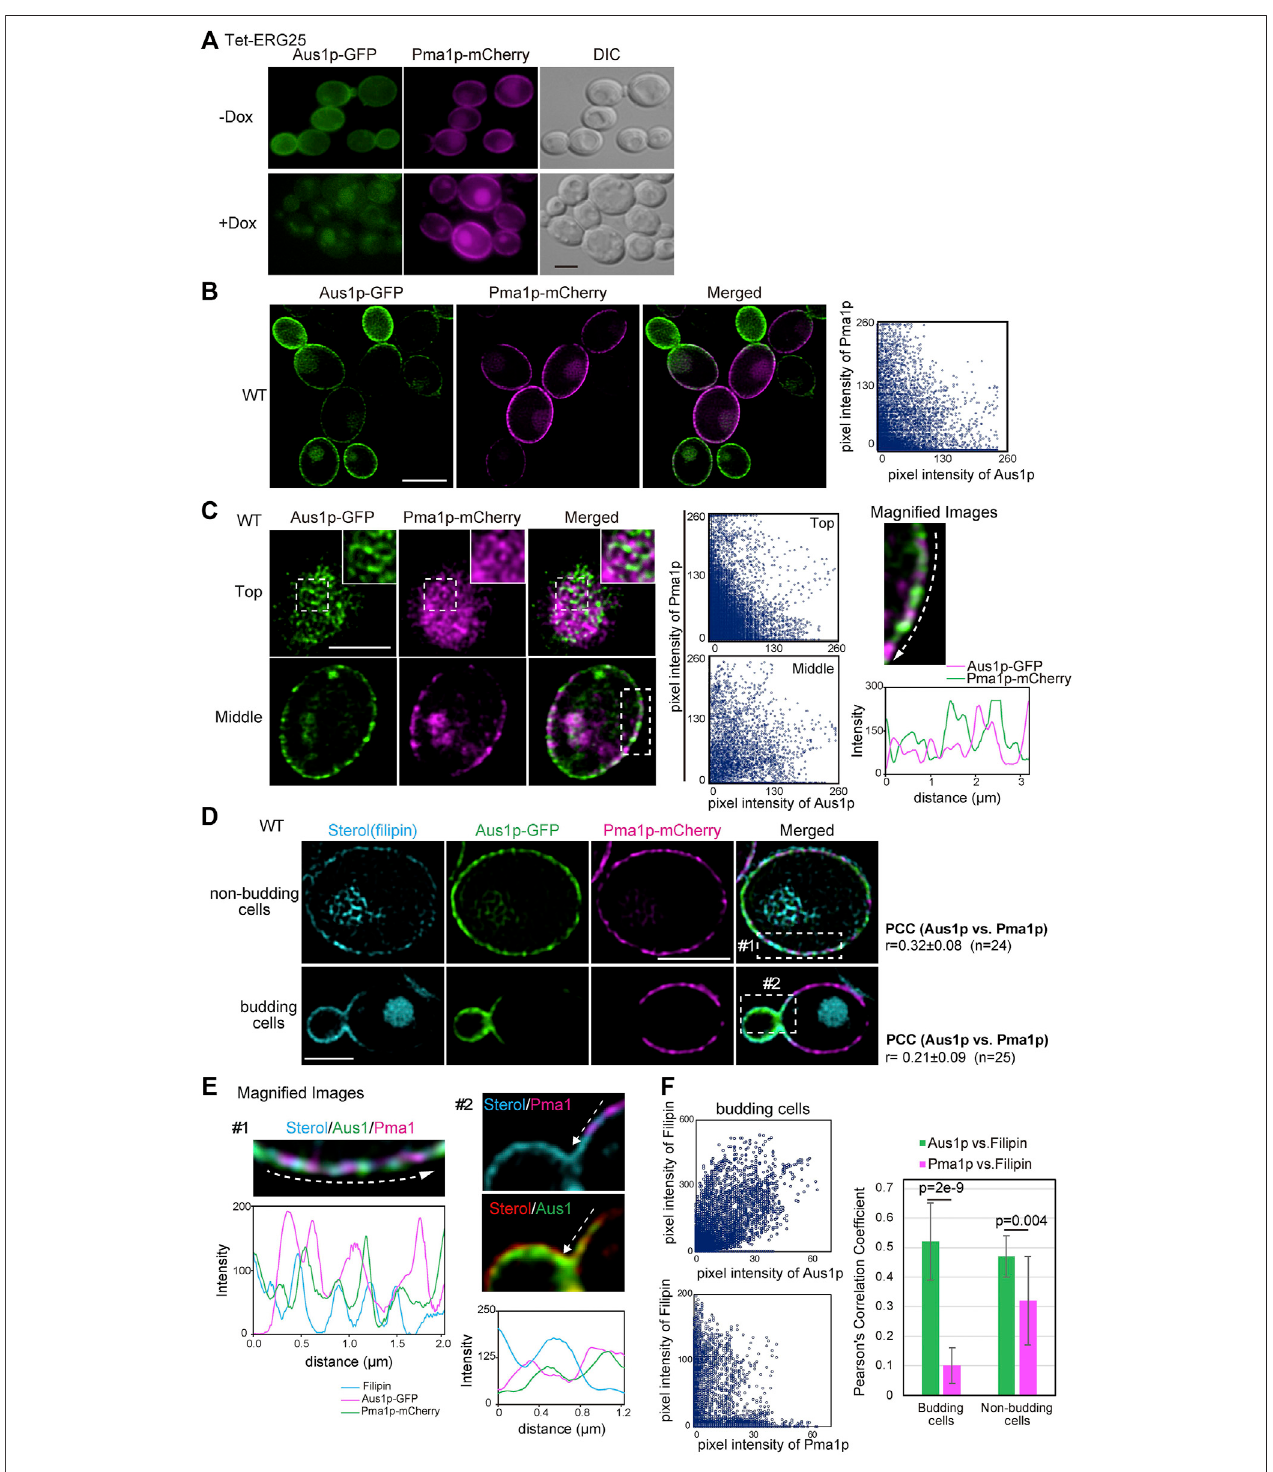
FIGURE 4 | ERG25 knockdown has no effect on the localization of Pma1p. (A) Effect of ERG25 knockdown on the localization of Pma1p. Tet-ERG25 cells that expresses Aus1p-GFP and Pma1p-mCherry (Tet-ERG25_Aus1G/Pma1R) were grown to exponential phase at 30 ° C in minimal medium containing 10% (v/v) bovine serum and observed using fl uorescence microscopy after incubation with or without 20 μ g/ml Dox for 3.5 h. (B) Distribution of Aus1p and Pma1p on the plasma membrane. Wild-type cells co-expressing Aus1p-GFP and Pma1p-mCherry (WT_Aus1G/Pma1R cells) were grown to exponential phase at 30 ° C in minimal medium containing 10% (v/v) bovine serum. Scatterplots of green and magenta pixel intensities of Aus1p-GFP and Pma1p-mCherry were performed using the Fiji/